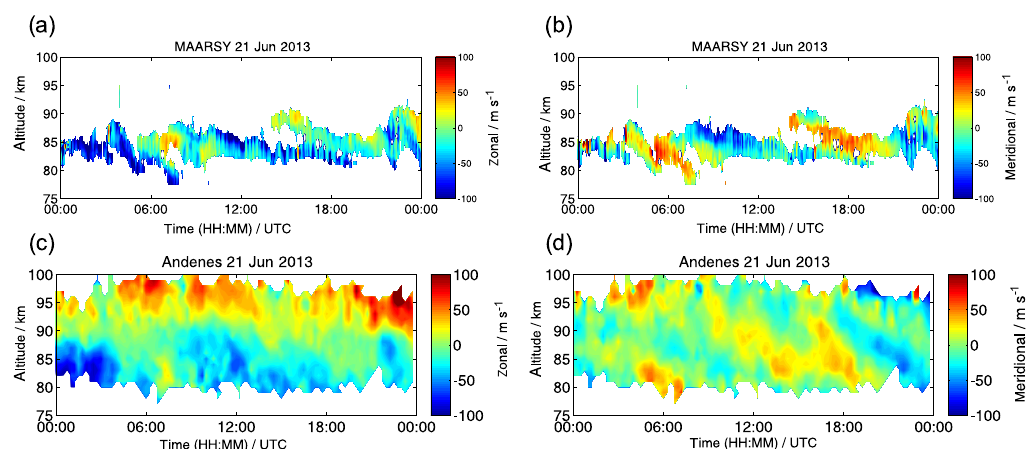
Figure 4. Color-coded zonal and meridional winds for 21 June 2013. Panels (a) and (b) show the observations from MAARSY. Panels (c) and (d) show the data from the collocated meteor radar.